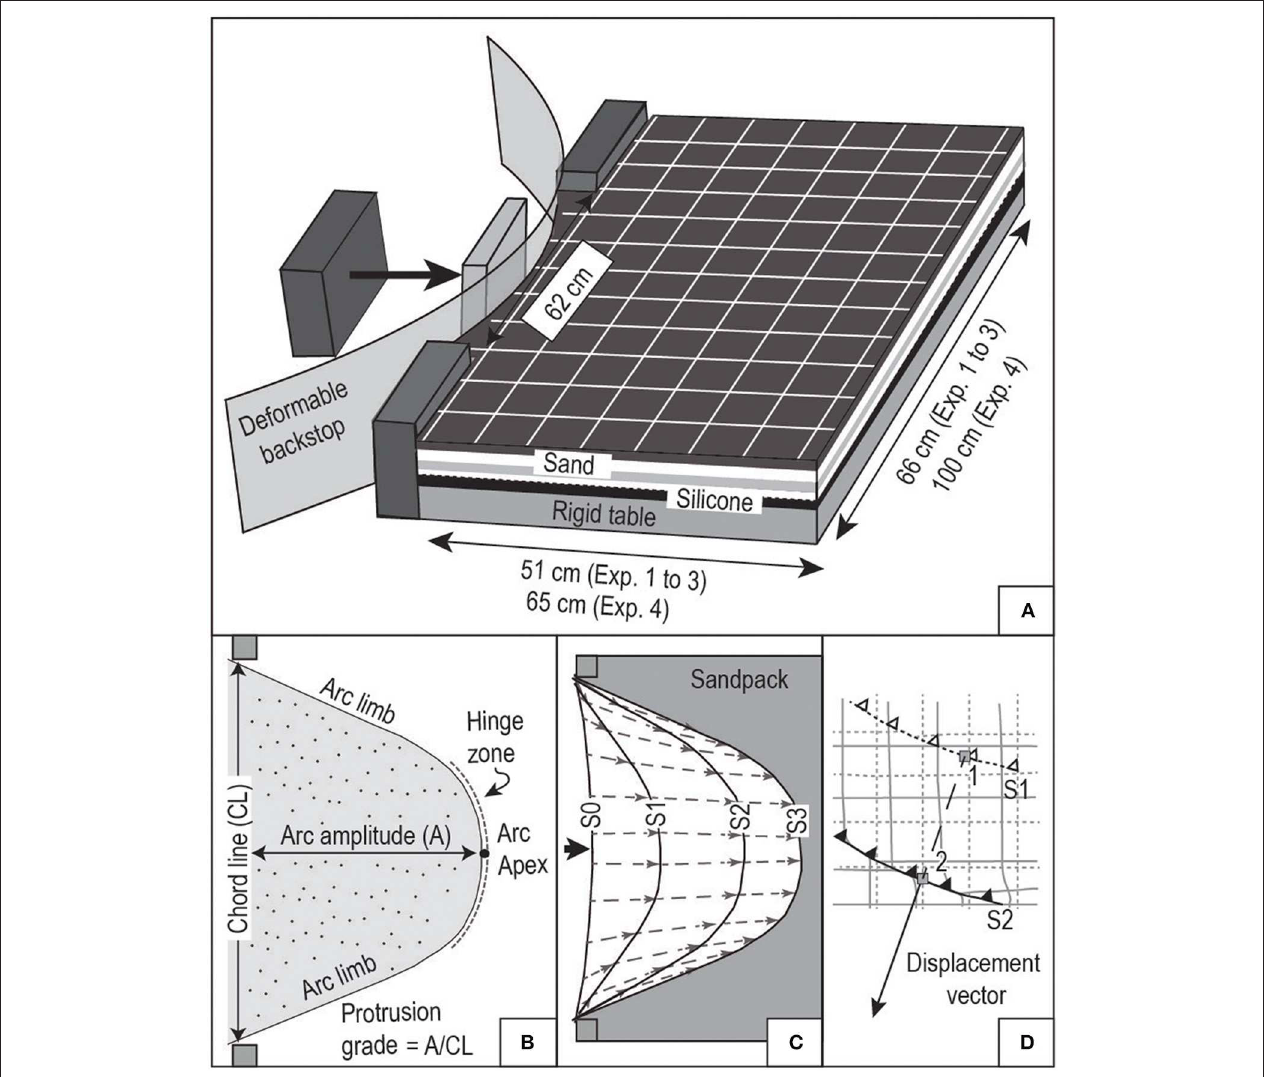
FIGURE 2 | (A) Simplified sketch of the experimental apparatus and model setup. (B) Sketch showing the terminology used in the paper. (C) Shape and particle displacement paths of the deformable indenter for different deformation stages (S1 to S3). (D) Sketch of the measurement of a displacement vector (arrow) between two successive deformation stages (S1 and